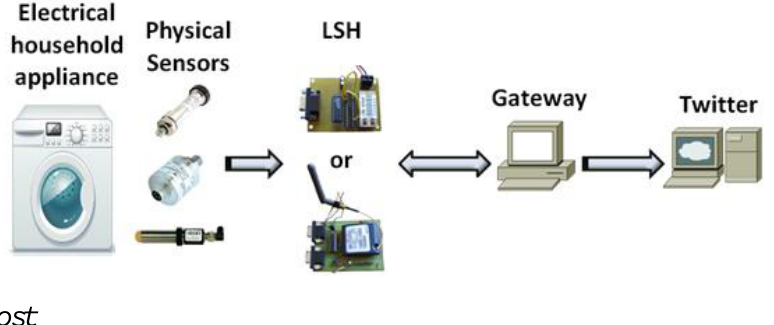
Figure 2. System architecture